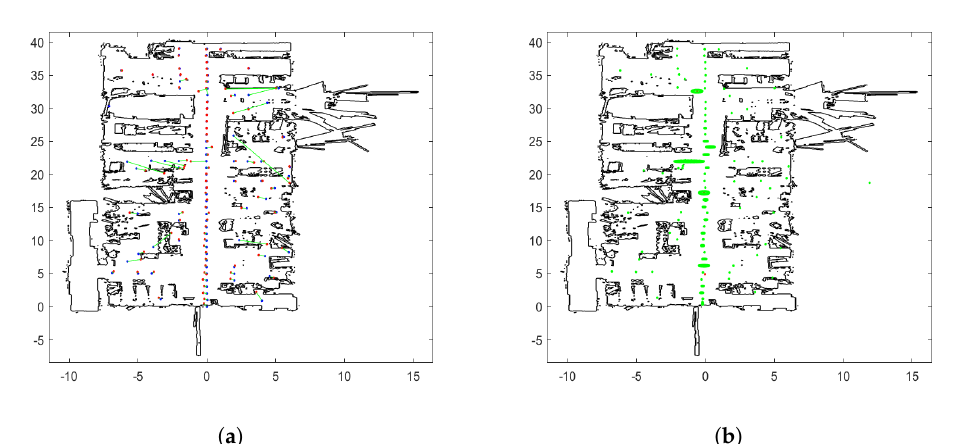
Figure A4. Static case results for GoT at 0.3m altitude. ( a ) Estimated positions from GoT (red) vs. ground-truth (blue) with connecting line (green). ( b ) Estimated positions from GoT (red) and standard deviation ellipsoids